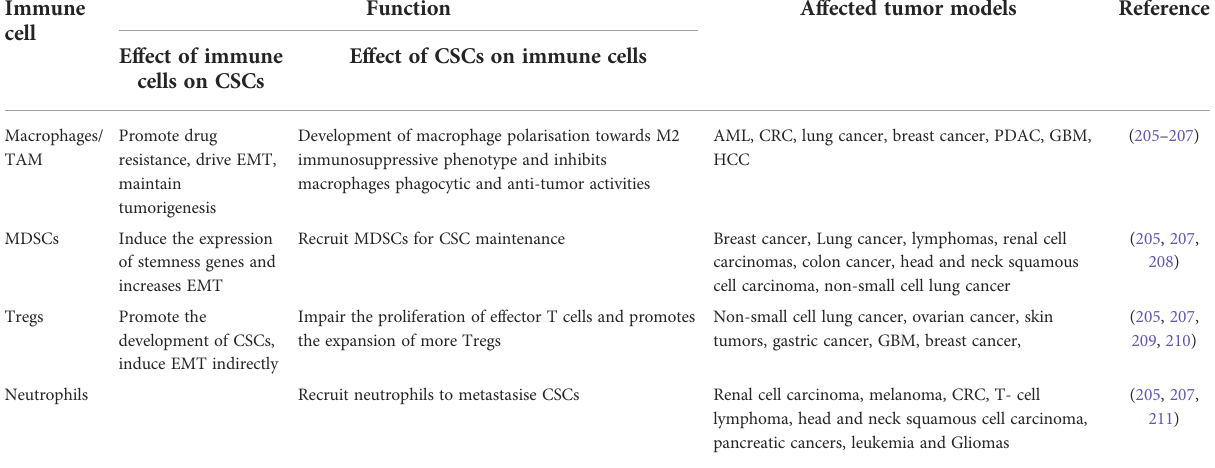
TABLE 1 A summarized interaction between CSCs and the immune